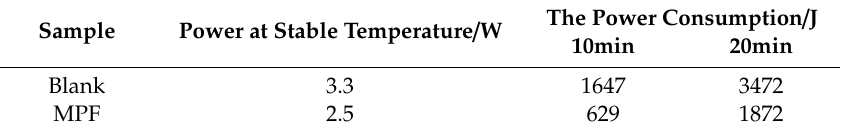
Figure 11. Thermal insulation performances in the low-temperature environment of the blank (The copper cup in the test module was not covered by the sample) and the MPF: ( a ) water temperature curve of the blank and the MPF; ( b ) the power consumption needed to maintain the water temperature of the blank; ( c ) the power consumption needed to maintain the water temperature of the MPF, the red circle in ( c ) highlights the MPF does not consume electrical power. Table 2. Thermal insulation results.